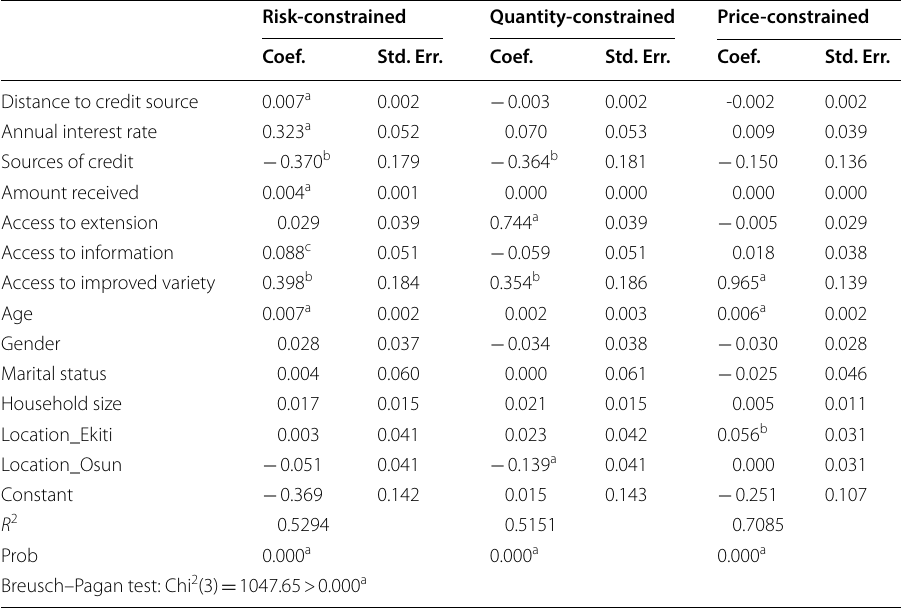
Table 3 Results of seemingly unrelated regression (SUR) for credit-constrained